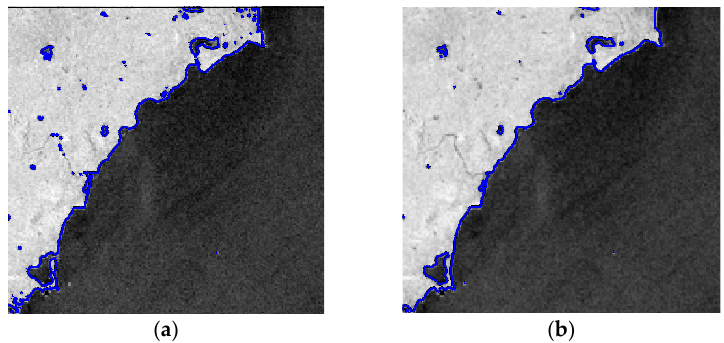
Figure 14. Shoreline extraction results: ( a ) Traditional geometric active-contour modeling method; ( b ) Proposed method.